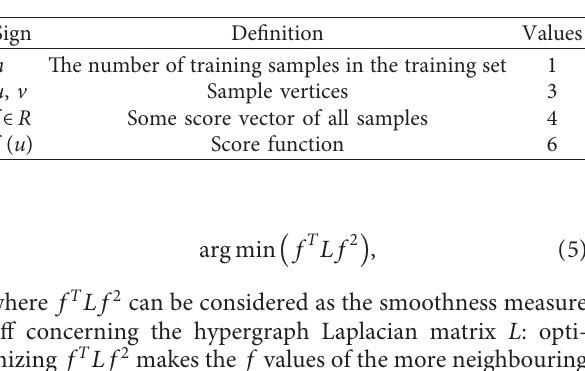
Table 1: Definition of important markers for hypergraph